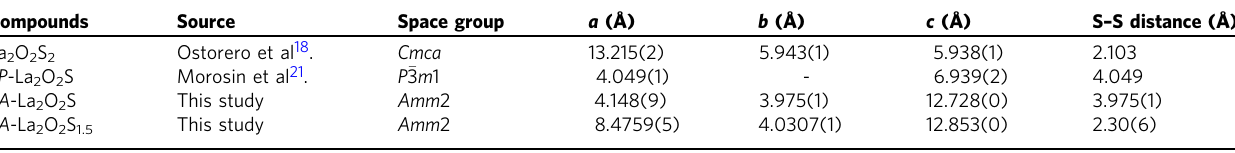
This study All of the indicated values were obtained from re fi nement of a respective XRD